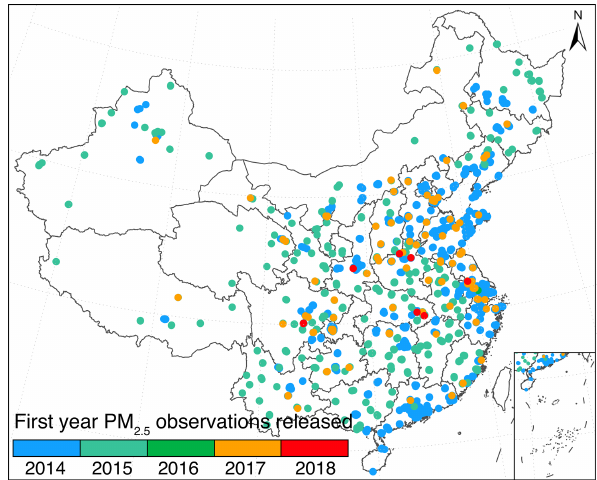
Figure 2. Spatial distribution of national ambient air quality mon- itoring network stations in China from May 2014 to April 2019. Circles with distinct color indicate the year in which the first PM 2 . 5 observation was publicly released in our retrieved data